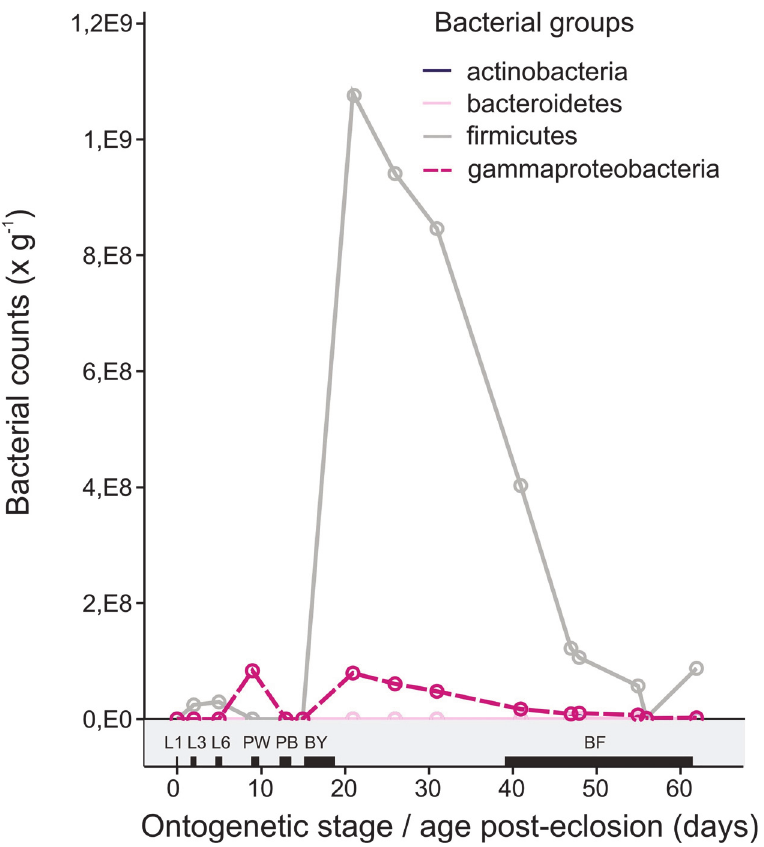
Fig 3. Dynamics of selected bacterial groups in the total gastrointestinal tract during development and aging of a “ single ” honey bee. Data were obtained by collecting pooled samples of sister honey bees from the eggs of the same oviposition. Young bees were marked by paint shortly after emergence. Legend in the grey field provides a link to the first experiment EXP2 described here and shows at which approximate time points the samples for EXP1 were